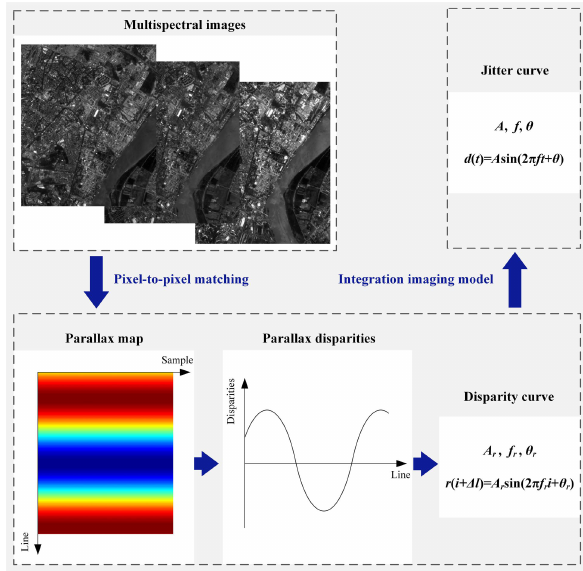
Figure 1. Overview of the presented method